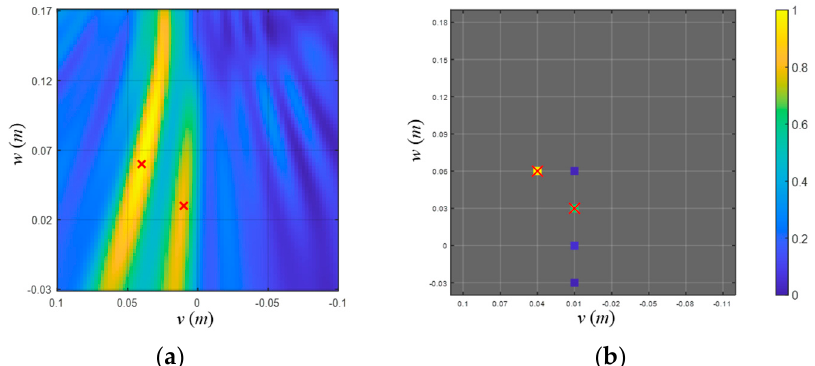
Figure 6. ( a ) Localization results using conventional (or Bartlett) beamformer. Ambiguity surfaces of the v–w (looking from the stern side) planes including two sources (marked with ‘x’) are displayed. The result was normalized with respect to the maximum value among the correlations. ( b ) Localization results using on-grid BSBL without basis mismatch. The five largest components (marked with colored squares) from the on-grid BSBL and two sources (marked with ‘x’) are projected onto the v – w (looking from the stern side) plane to visualize the 3D localization results. The lattice denotes the grid positions, and the results were normalized with respect to the maximum value among the components. The figure legend indicates the value of the components, which are normalized with respect to the maximum value.